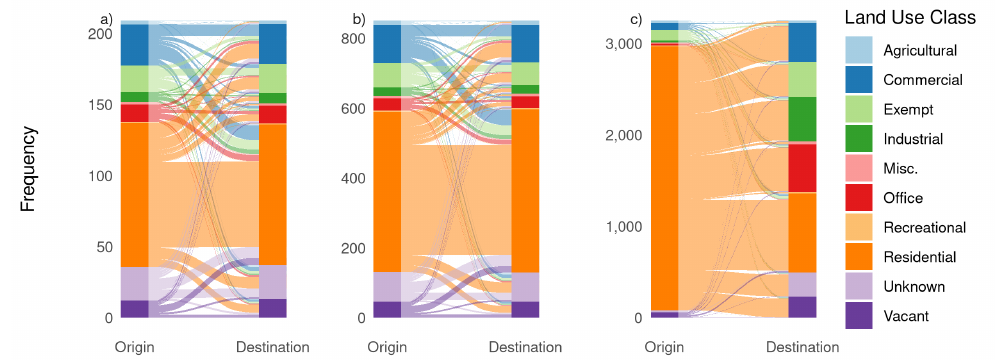
Figure 8. Sankey diagrams of land-use pairs from ( a ) Twitter flows during rush hours, ( b ) Twitter flows outside of rush hours and ( c ) LODES data (magnitude ×